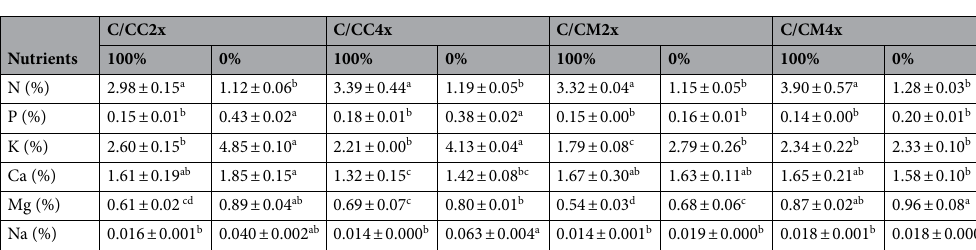
Table 1. Total content of macronutrient in leaves of common clementine scion grafted onto different rootstocks. Nitrogen (N), phosphorus (P), potassium (K), magnesium (Mg), calcium (Ca) and sodium (Na) content in leaves of common clementine scion grafted onto diploid (C/CC2x) and doubled diploid (C/CC4x) Carrizo citrange and diploid (C/CM2x) and doubled diploid (C/CM4x) Citrumelo 4475 rootstocks grown in nutrient reference solution (100%) and without nutrient solution (0%). Values are means (± standard error) of 3 independent measurements from 3 samples for each scion/rootstock, i.e. one per tree ( n = 3). One sample was obtained by pooling 8 fully-expanded leaves. Data were analyzed using ANOVA and Fisher LSD tests ( p < 0.05). Different letters indicate significant differences between the four scion/rootstock combinations and